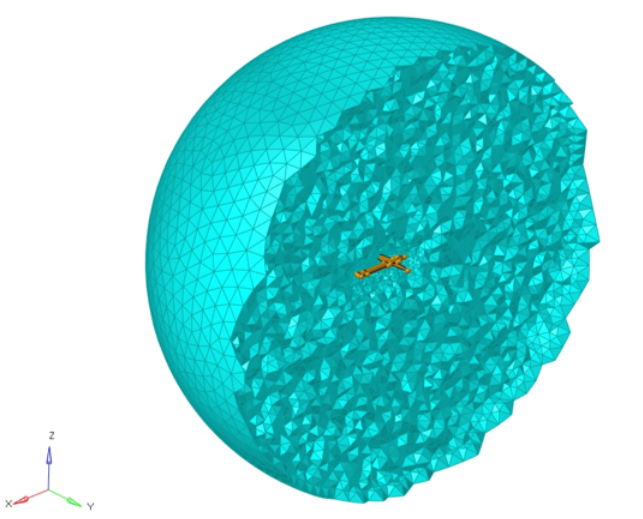
Figure 15. Sketch of the free-field FEM model of the cavitator.